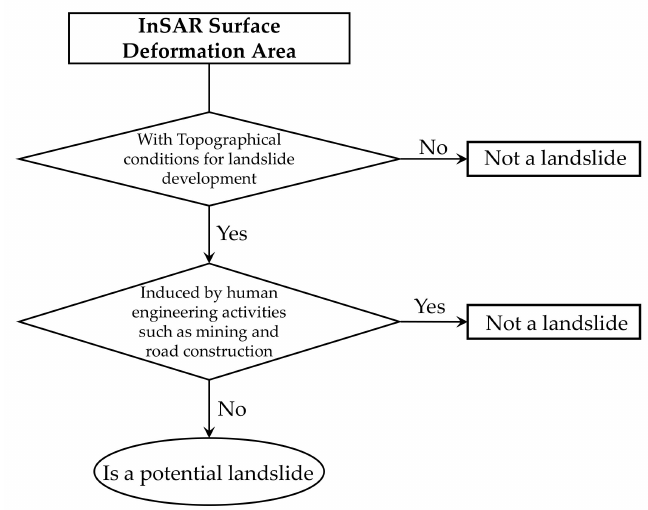
Figure 5. The identification flow chart of potential landslide based on InSAR technology. (1) The surface deformation value changes suddenly, but there are no suitable terrain conditions for the development of landslides, so the marked area cannot be considered as a potential